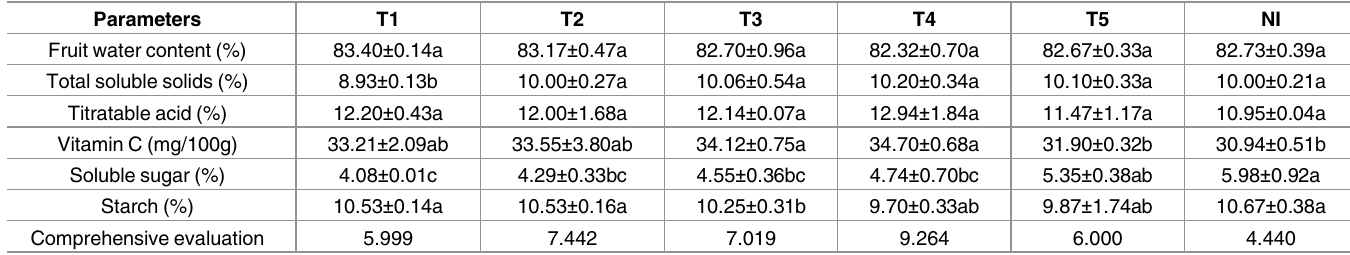
Table 4. Effects of different irrigation treatments on fruit quality of mango. Parameters